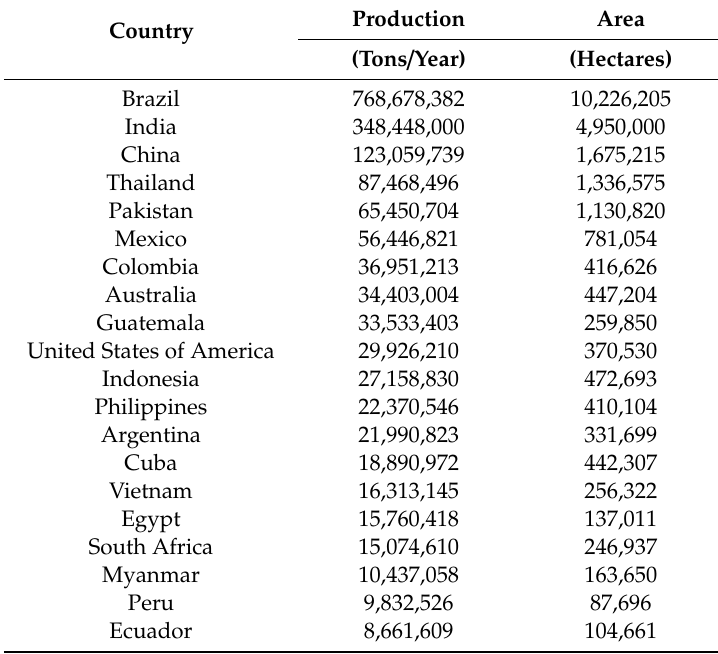
Table 1. Sugarcane production and area of cultivation in 20 main countries [11,12]. Production Area Country (Tons / Year)